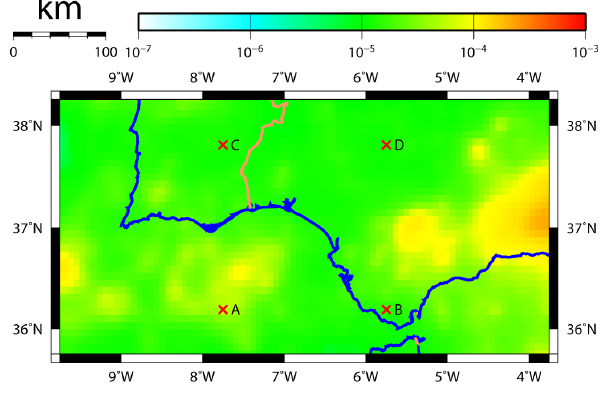
Figure 6. Annual rate of occurrence of events per km 2 with M w > 3 . 5. Points A to D indicate the locations where the activity is plotted in Fig.